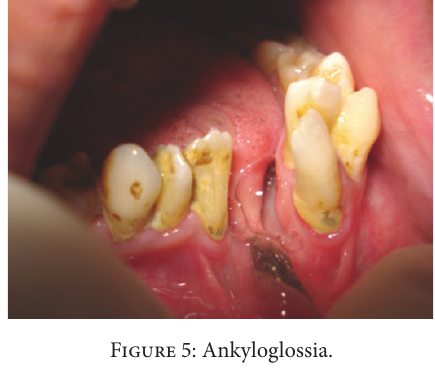
Figure 5: Ankyloglossia.